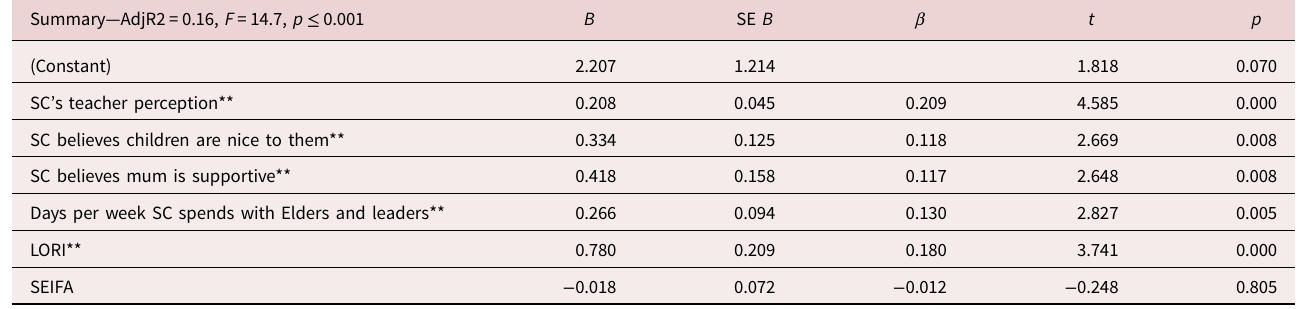
Table 3. Mathematics self-concept ×selected independent variables